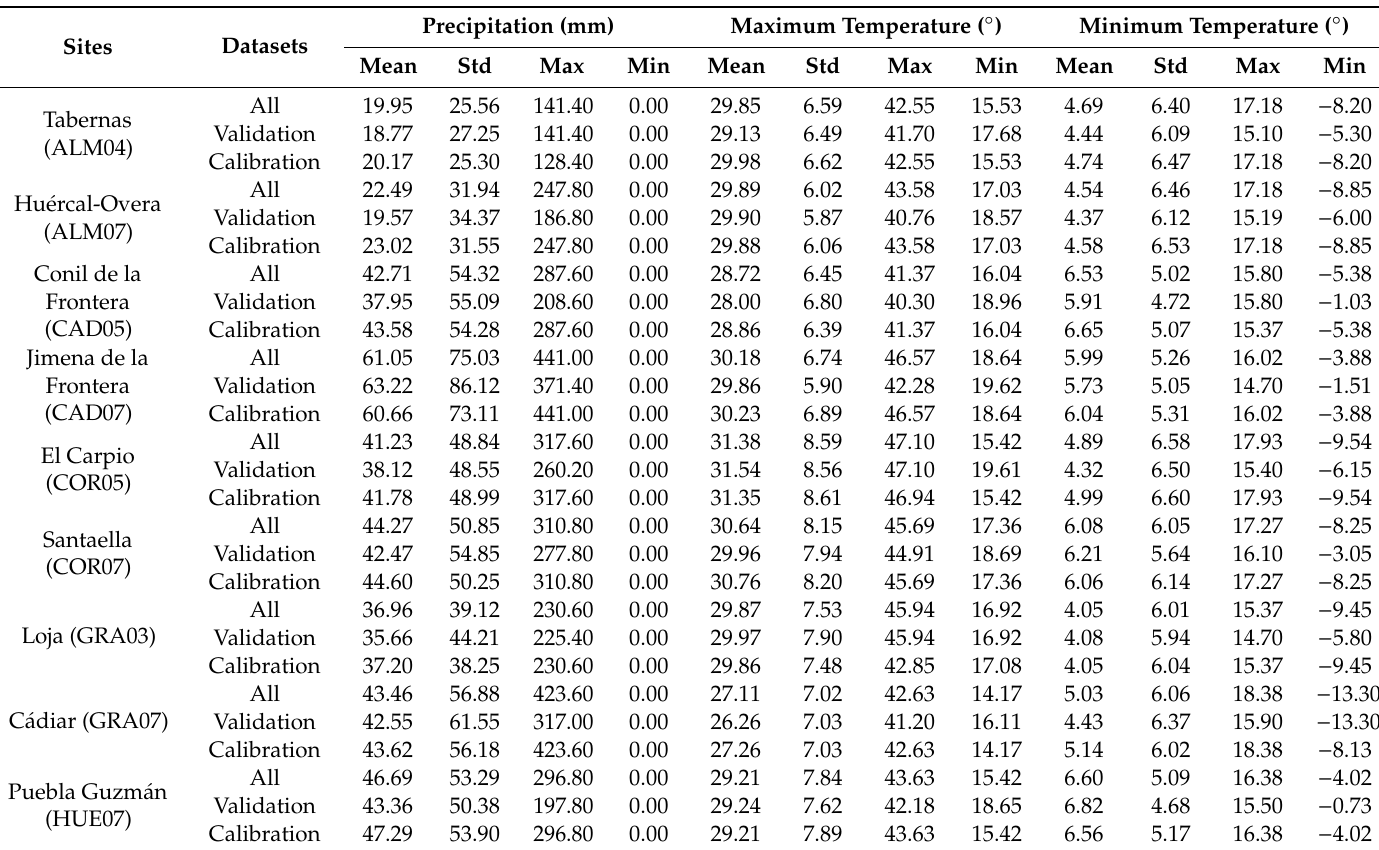
Table 2. Statistics of monthly precipitation, maximum and minimum temperature (Std: Standard Deviation; Max: Maximum; Min: